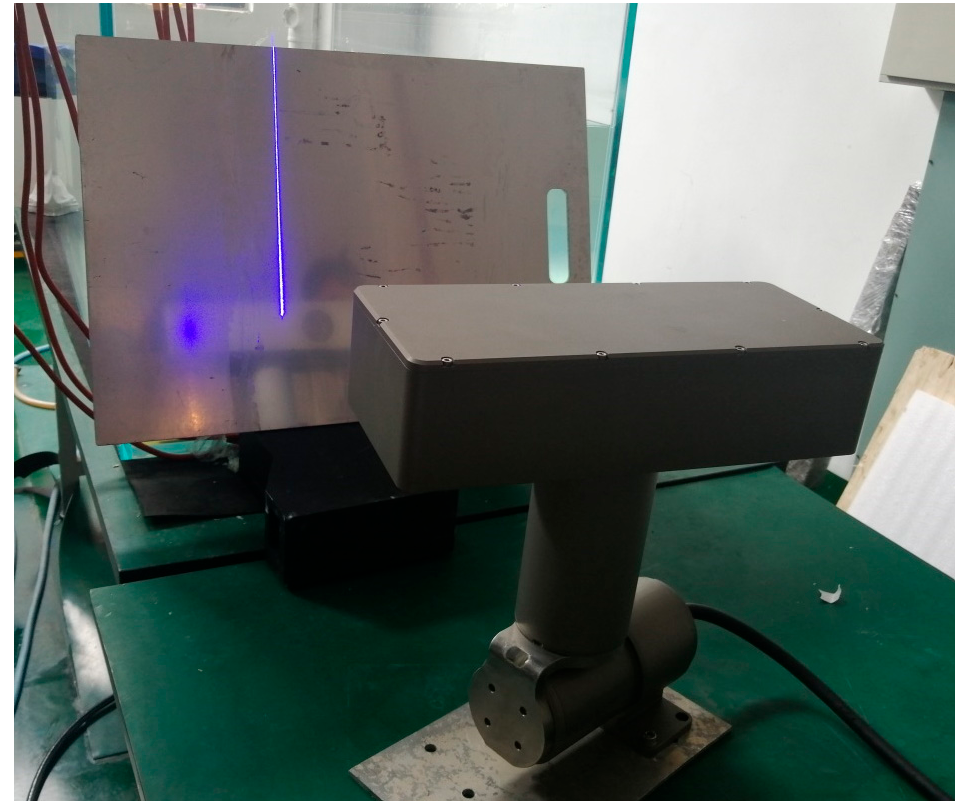
Figure 5. Calibration experiment of self-rotating, LSL scanning, 3D reconstruction system based on plane constraints.